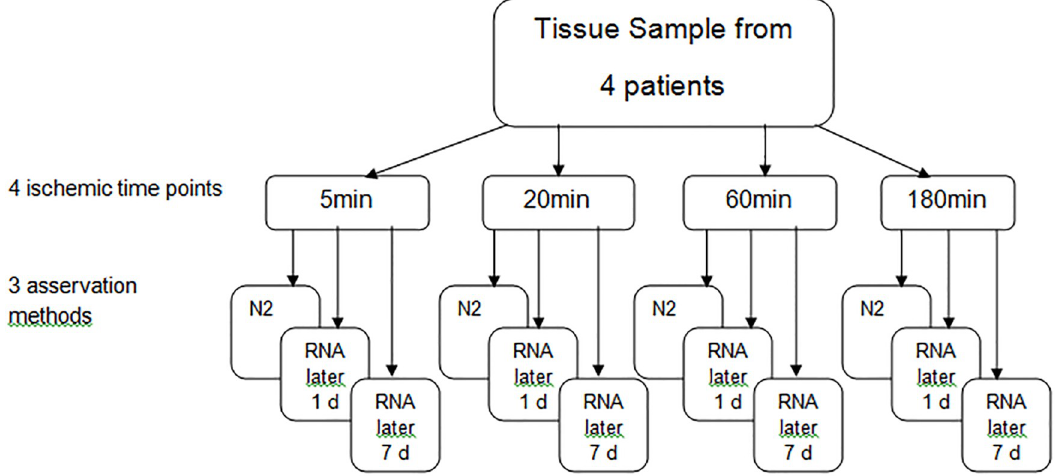
Fig 1. Experimental design. Tumor tissue samples from 4 lung cancer patients were cut into aliquots and processed after 4 different periods of time, with 3 different methods before long term storage and subsequent RNA